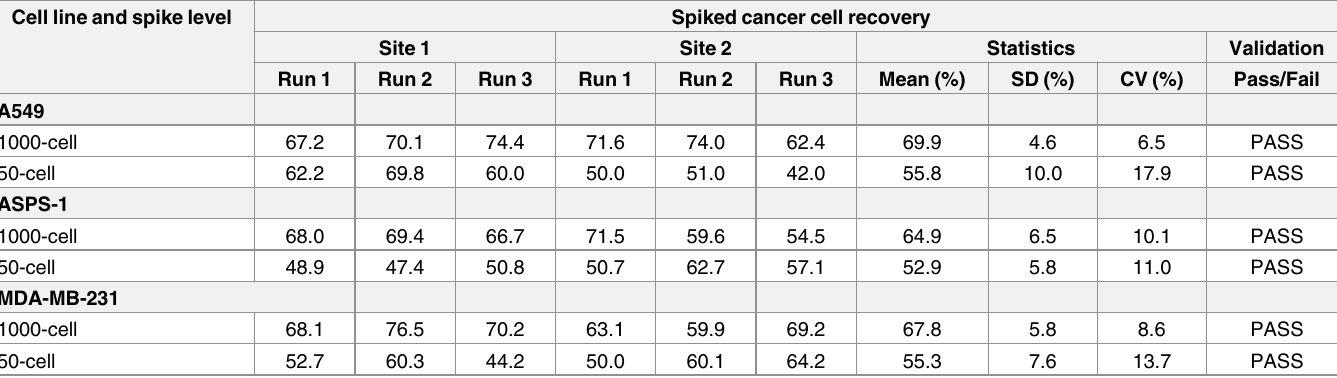
Spiked cancer cell recovery at cancer cell spike levels 1000 and 50 per 10 7 PBMCs after ApoStream ® separation at two testing sites. The PASS/FAIL acceptance criteria was defined prior to study initiation as coefficient of variation (CV) < 20% for cancer cell recovery performance between the two testing sites.